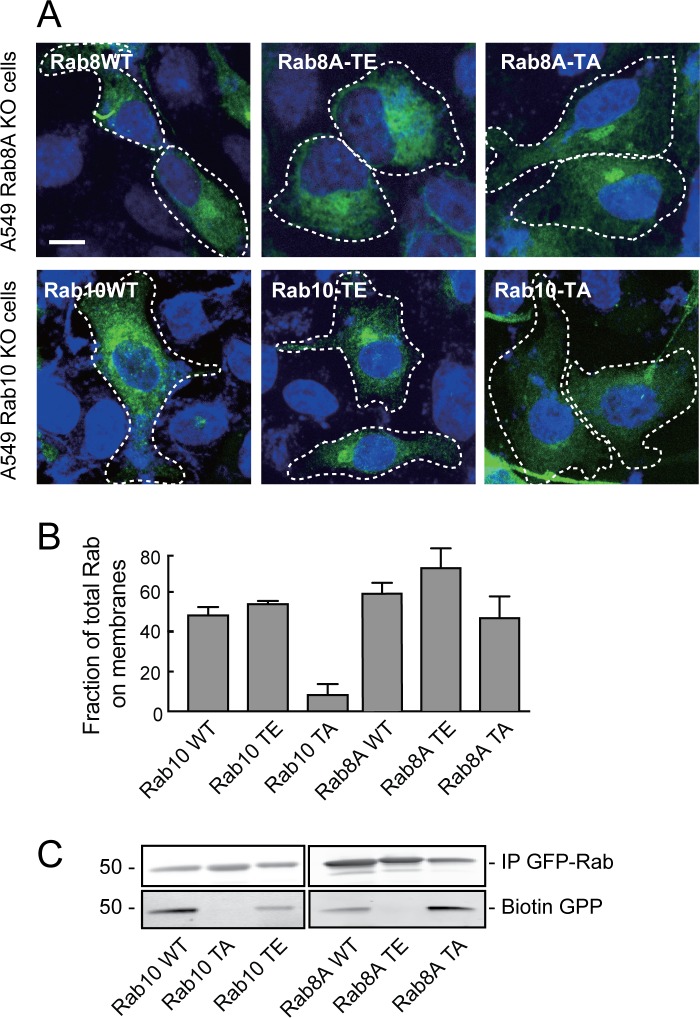
Rab8A and Rab10 phospho-site mutants are non-functional proteins.(A) Rab8A-KO and Rab10-KO A549 cells were infected with lentivirus to stably express wild type (WT), phospho-mimetic (TE) or non-phosphorylatable (TA) mutants of Rab8A and Rab10, respectively. 24 hr post transfection, cells were fixed and stained with anti-GFP. (B) HEK293T cells were transfected with wild type (WT), T73E (TE) or T73A (TA) mutant GFP-Rab10 or GFP-Rab8A as indicated. After 24 hr, cells were fractionated into membrane and cytosol and 50 µg membranes and the equivalent volume of cytosol was immunoblotted using anti-GFP antibodies. Graph indicates the percent of total Rab10 or Rab8A protein that was membrane associated. (C) In vitro prenylation measured using cytosol fractions from (B), incubated for 4 hr with biotin-geranyl pyrophosphate at room temperature. The reaction was immunoprecipitated with GFP binding protein-Sepharose and samples were immunoblotted for biotin using Strepatavidin-Alexa 800 and anti-GFP.